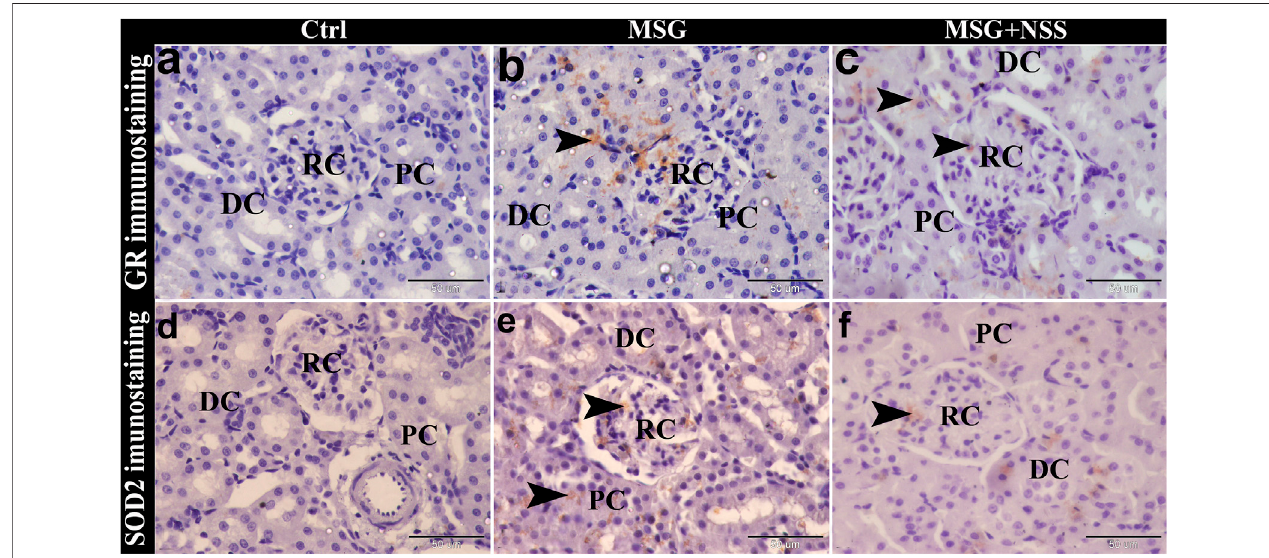
FIGURE 3 | Photomicrograph of GR and SOD2 immunostaining in the kidney showing the protective effect of NSS on MSG induced renal damage. The control group (Ctrl) showed negative immunostaining ofGR (A) and SOD2 (D) intherenal corpuscle(RC),proximal convoluted tubules (PC),and distal convoluted tubules(DC). MSGgroup showedpositiveimmunostaining ofGR (B) andSOD2 (E) (arrowheads)intheRC,PC,and DC.MSG+NSSgroupshowedweakimmunostainingofGR (C) and SOD2 (F) (arrowheads) in the RC, PC, and DC. Original magni fi cation, ×400, scale bar = 50 μ m.